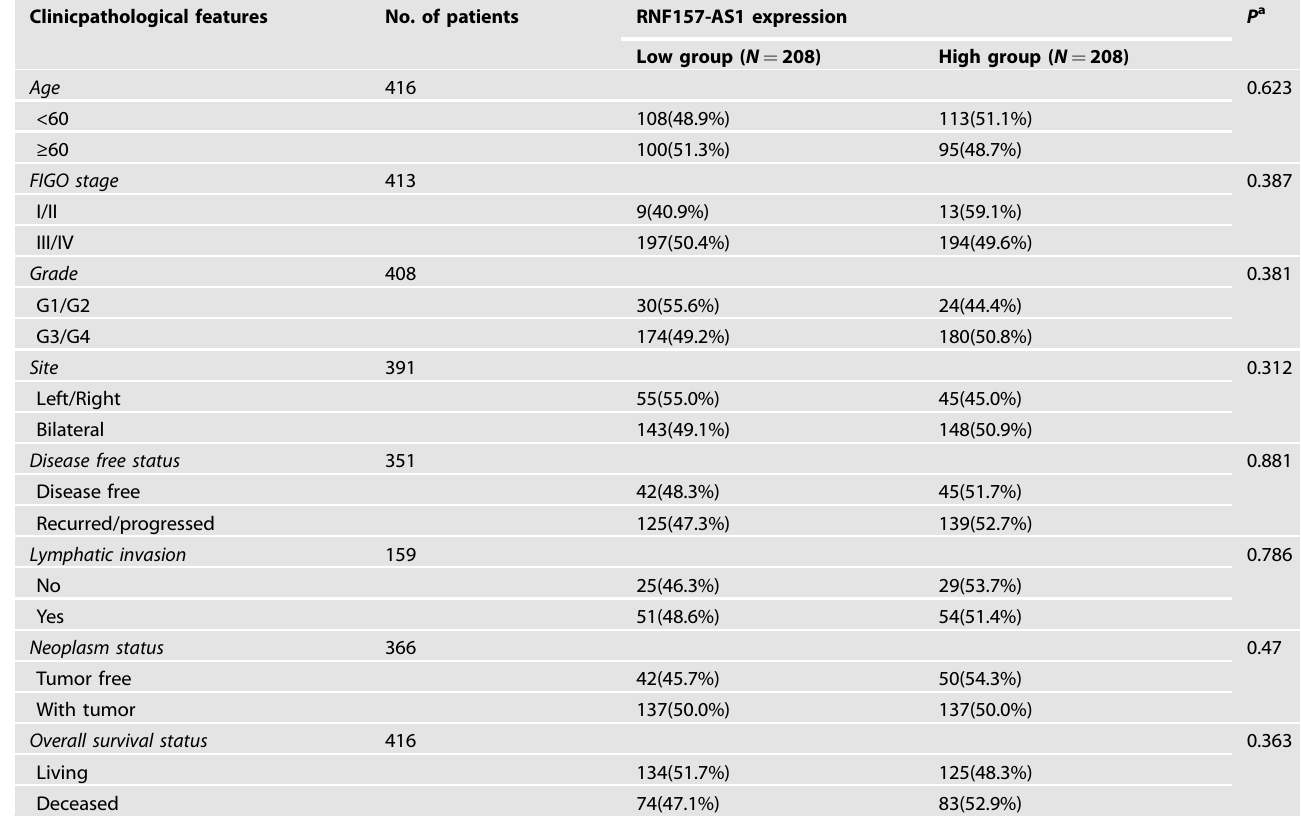
Table 1. Clinicopathological features of RNF157-AS1 in EOC patients based on TCGA. Clinicpathological